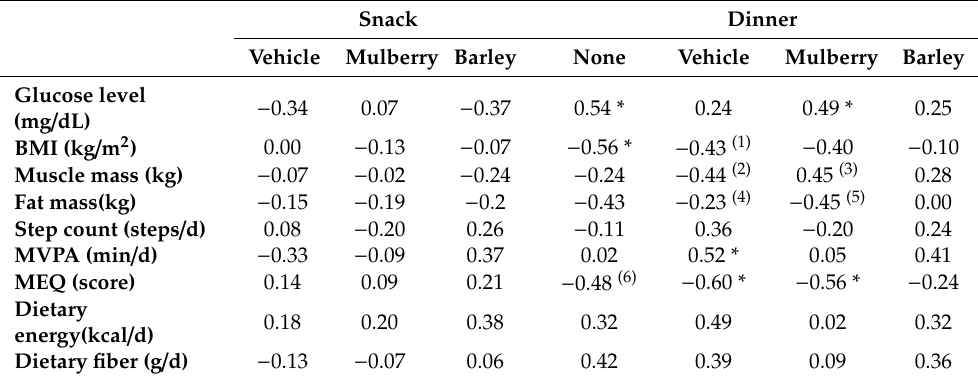
Table 5. Correlation between physiological factors and snack / dinner glucose levels. Snack Dinner Vehicle Mulberry Barley None Vehicle Mulberry